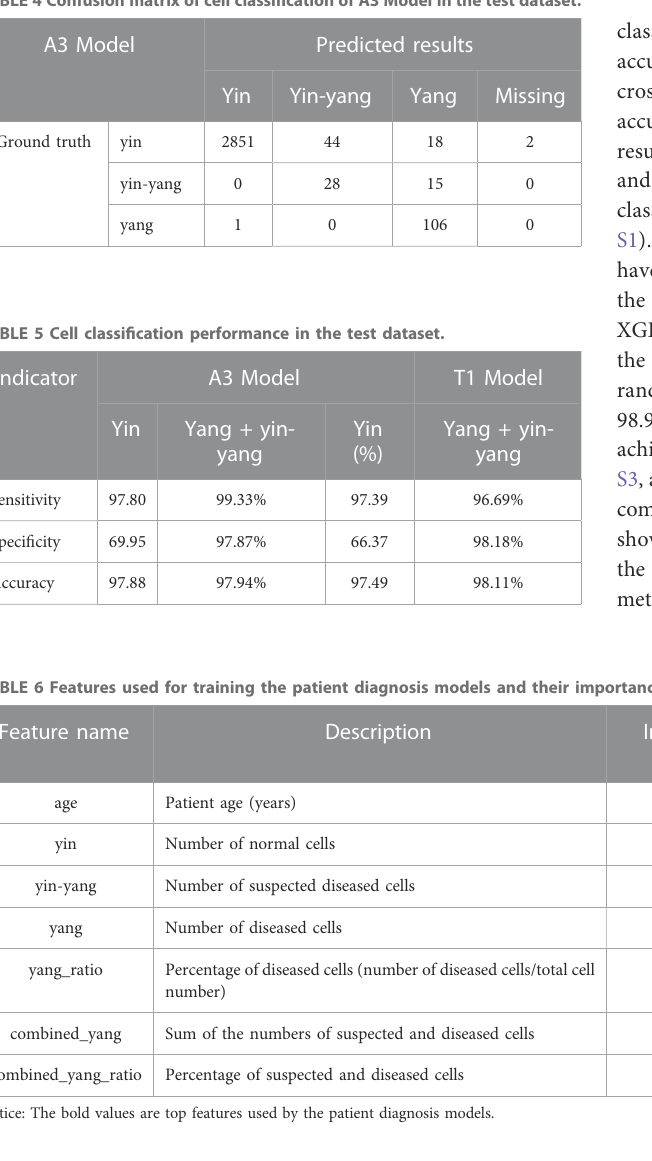
TABLE 4 Confusion matrix of cell classi fi cation of A3 Model in the test dataset.